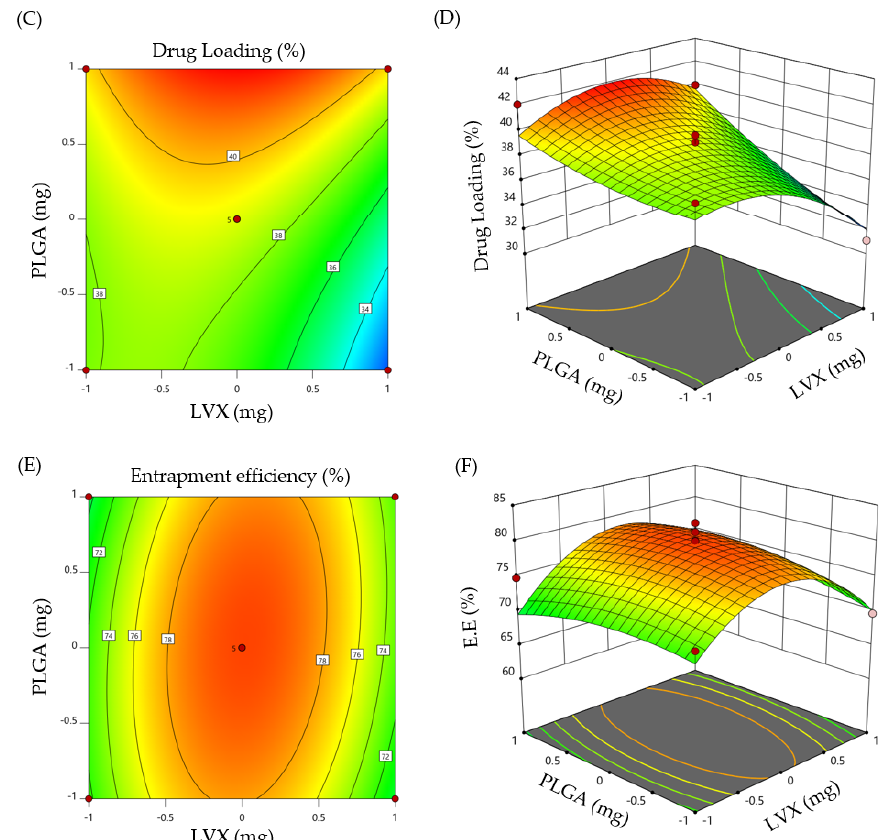
Figure 1. ( A ) Contour plot of particle size (Y 1 ); ( B ) 3D surface plot for Y 1 ; ( C ) Contour plot of drug loading (Y 2 ); ( D ) 3D surface plot for Y 2 ; ( E ) Contour plot of entrapment efficiency (Y 3 ); and ( F ) 3D surface plot for Y 3 .